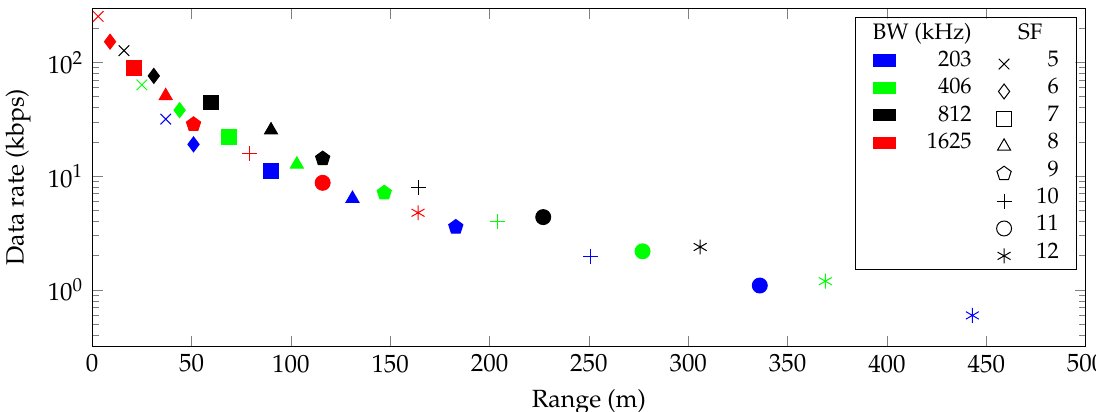
Figure 4. Communication range and data rate for every combination of spreading factor (SF) and bandwidth (BW) in an urban